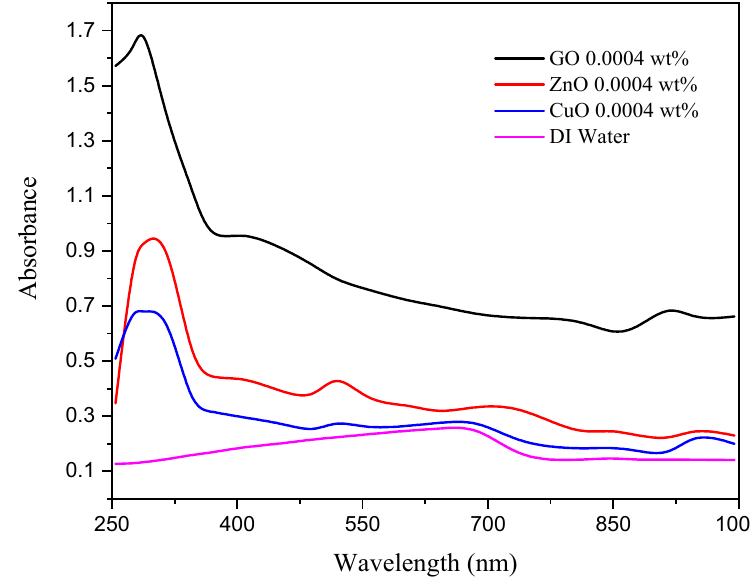
Figure 2. UV absorption spectra of GO, ZnO, and CuO nanoparticles at 0.0004 wt % concentration.